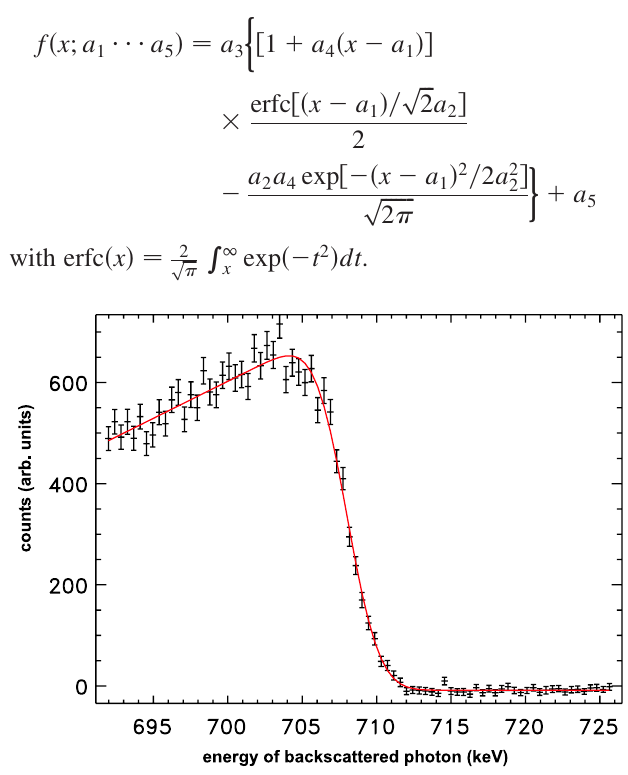
FIG. 5. (Color) Close-up of the cutoff edge of the backscattered photons for 628 MeV operation of the